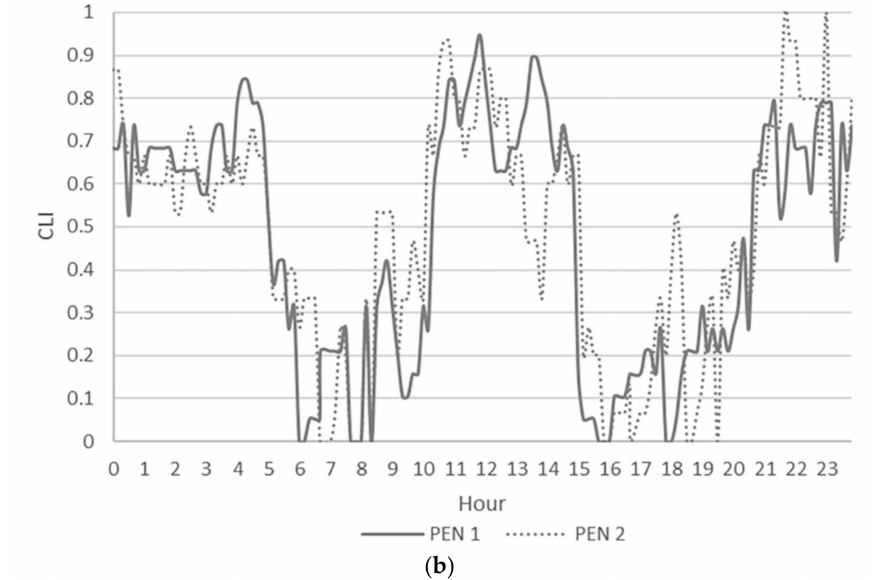
Figure 5. Cow Feeding Index (CFI) ( a ) and Cow Lying Index (CLI) ( b ) during the fifth day of W2, when the sprinkler system in the feeding alley was activated in pen 1 and deactivated in pen 2.